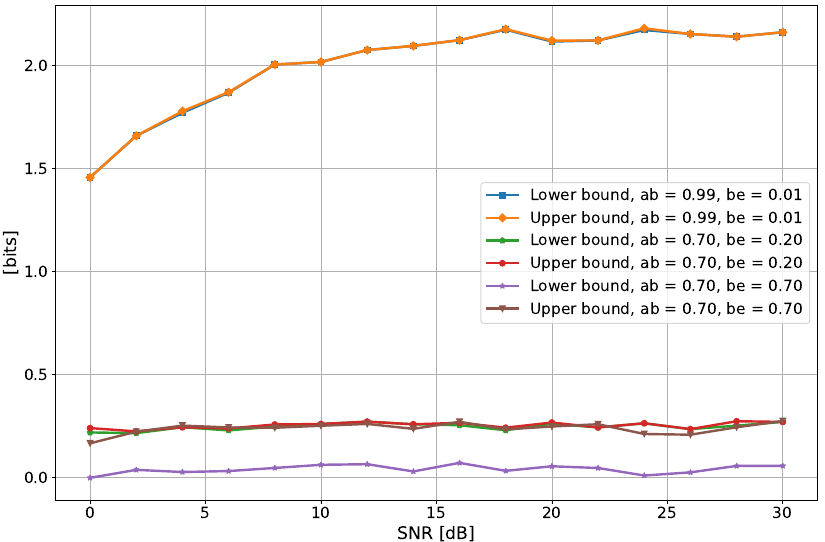
Figure 9. Secrecy key rate as a function of the SNR of Alice and Bob, for different values of the correlation and with 1 filter. In the legend, “ab” and “be” stand for Alice–Bob correlation and Bob–Eve